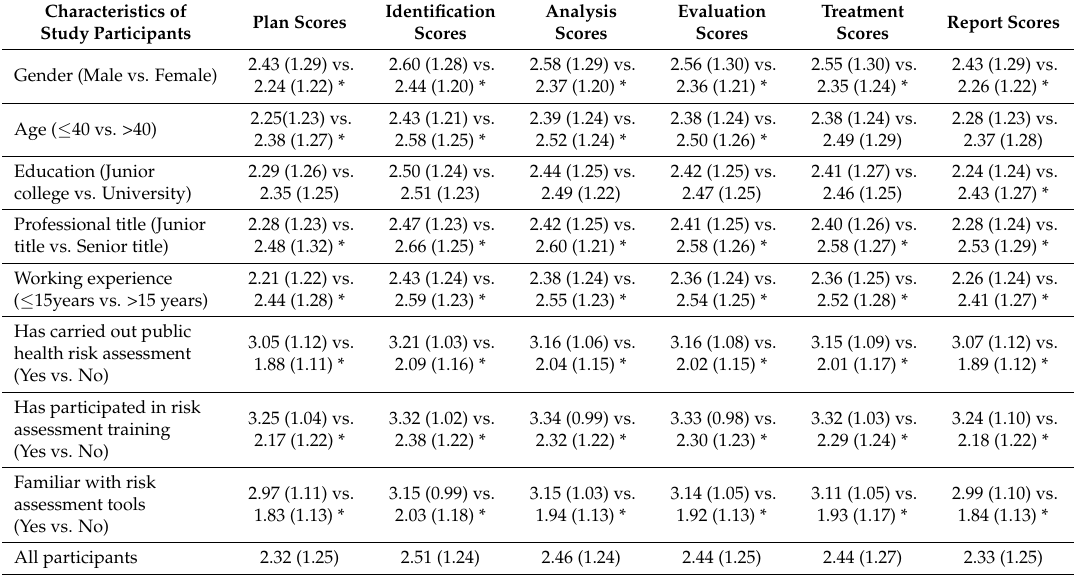
Table 3. Bivariate analysis between self-rated scores on key processes of risk assessment and characteristics of study